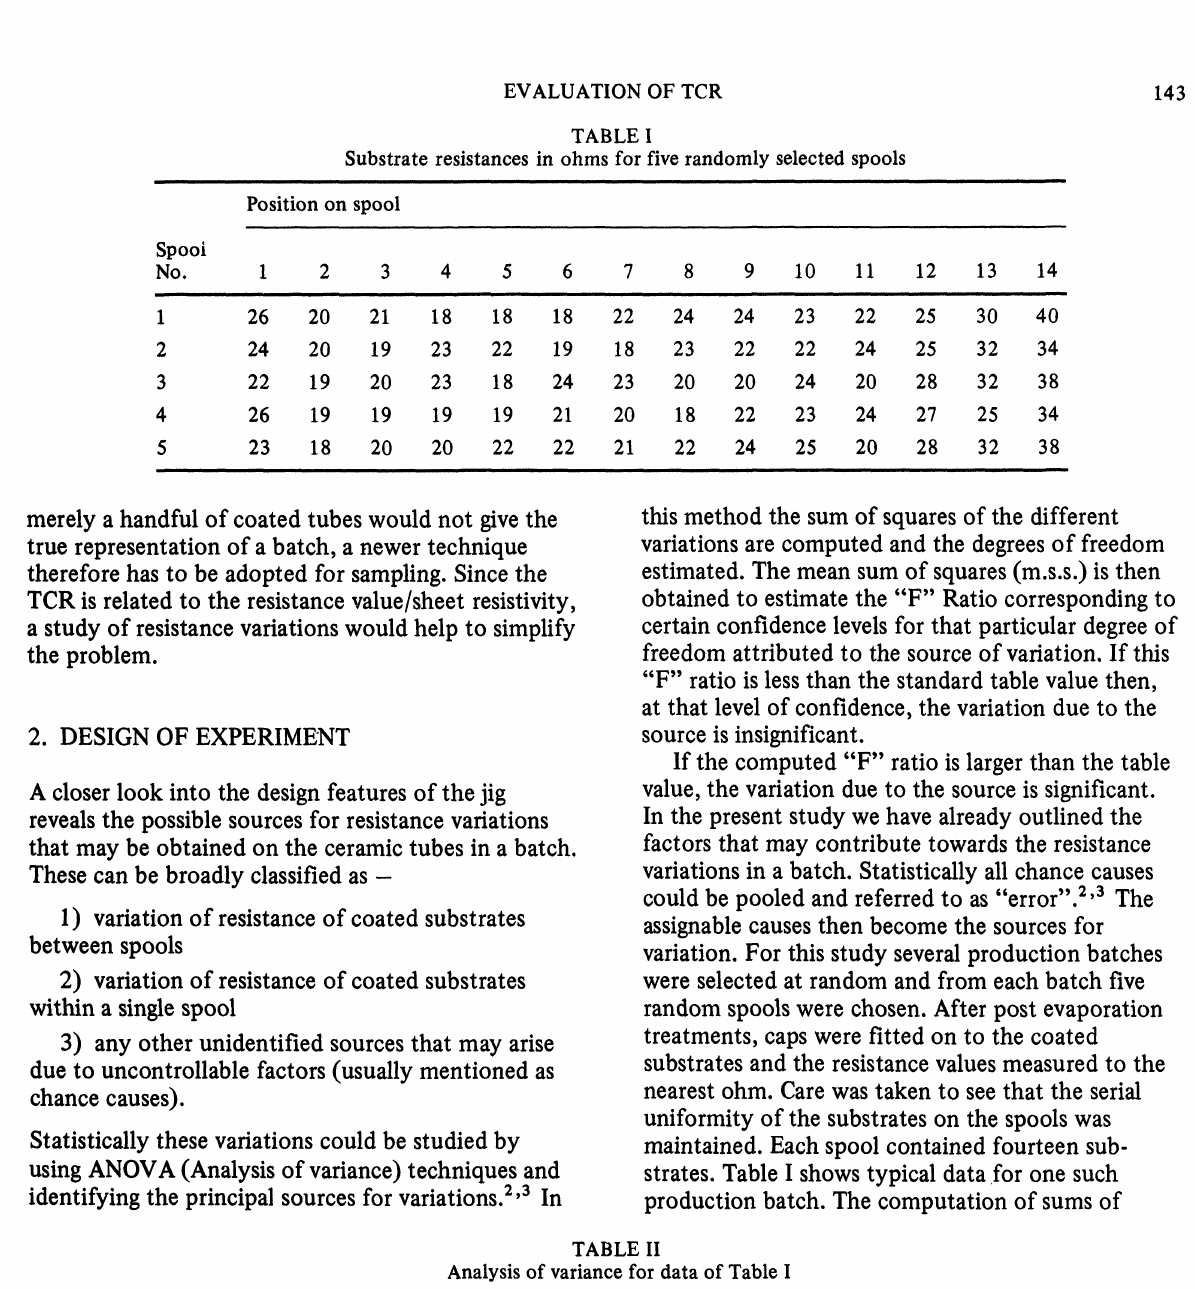
TABLE II Analysis of variance for data of